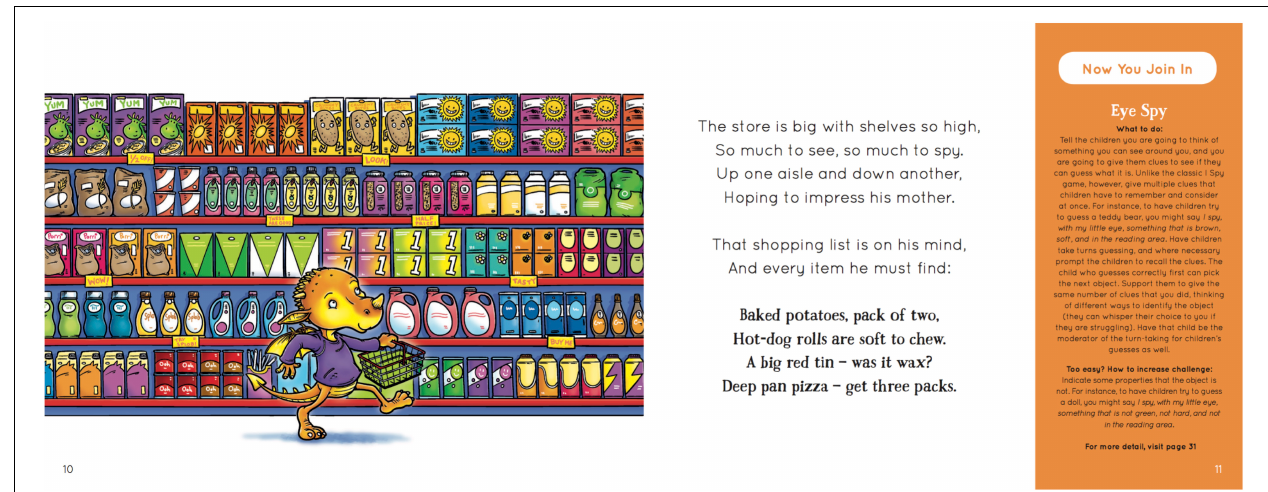
FIGURE 1 | Example story page and linked child activity pertaining to cognitive self-regulation. The picture books were developed so that educators could read the rhyming story to children, and after the story facilitate an activity linked to primary plot points – as a soft entry into doing the activities with children. This example is from a book with a cognitive self-regulation storyline – the main character must remember a shopping list despite distraction and competing interests. The rhyming story and associated image take up the majority of the page, while an activity that can be completed after the story – which is linked to the plot of the current page – is provided in the panel on the right. This image is reproduced with permission of the publisher, Ceratopia Books